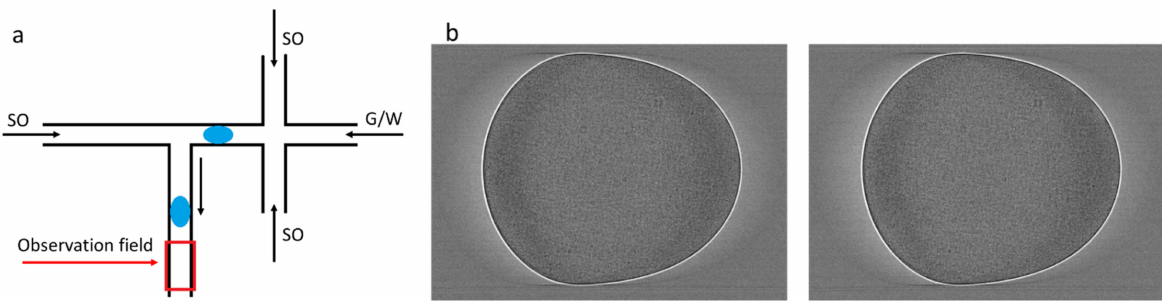
Figure 2. ( a ) Schematic of the microfluidic device and ( b ) an example of two subsequent images with speckle patterns used in PIVlab to extract velocity fields. Drops are moving from the left to the